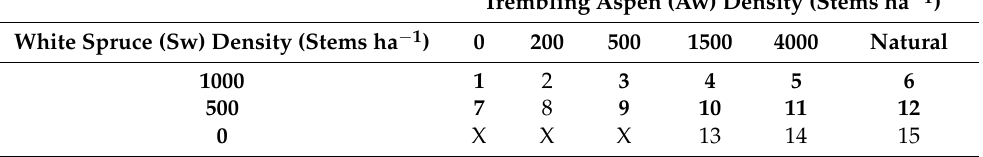
Table 1. Spruce and aspen treatment densities established in each replicate in the WESBOGY Long- Term Study (i.e., one replicate of each of the 15 treatments was established in each replicate). For the study presented in this paper, white spruce were measured in the Big River installations in the 10 treatments shown in bold out of the 15 treatments that had been established for the study. Trembling Aspen (Aw) Density (Stems ha − 1 ) White Spruce (Sw) Density (Stems ha − 1 ) 0 200 500 1500 4000 Natural